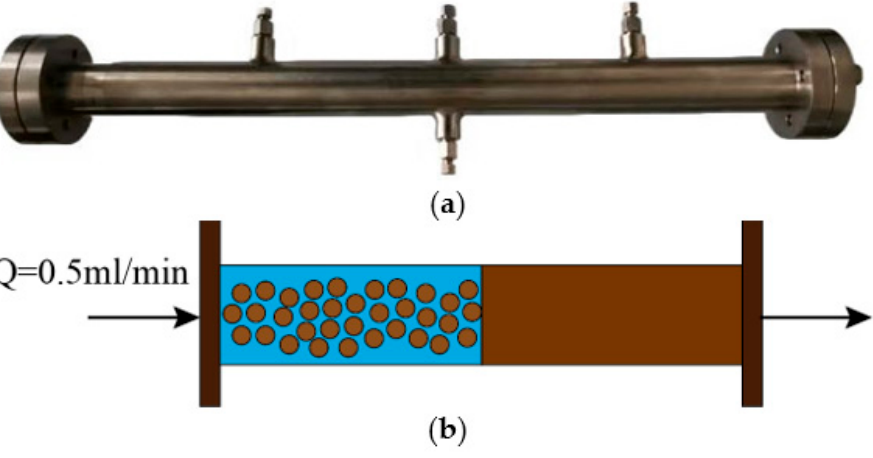
Figure 7. ( a ) Photo of the prepared sandpack. ( b ) Schematic view of the sandpack. The sandpack was initially saturated with oil, then injected by pre-prepared O/W emulsions.